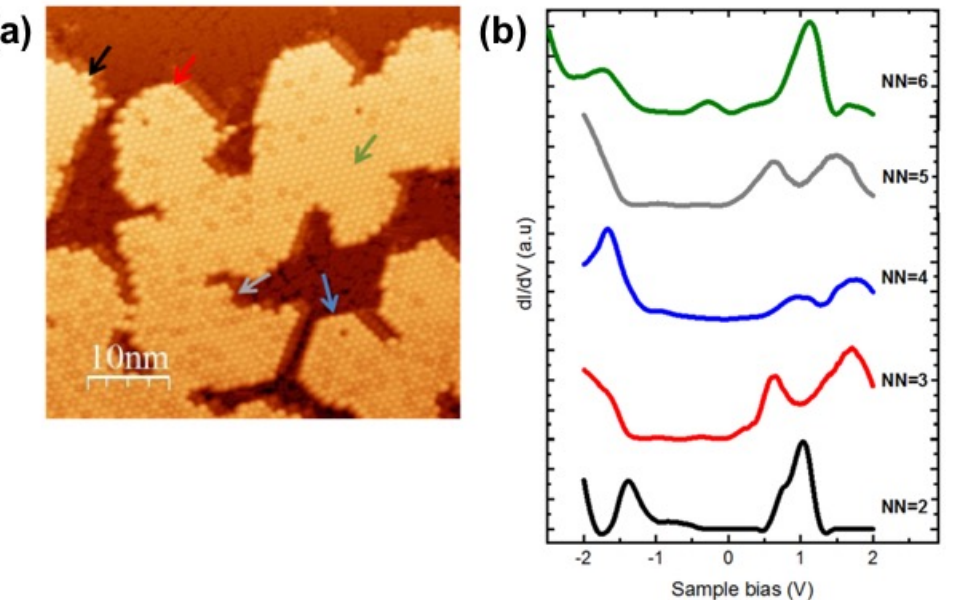
Figure 4. ( a ) STM topography of C 60 islands grown on ZnPc/Ag(111). The arrows are highlighting topography of C islands grown on ZnPc/Ag(111). The arrows are highlighting the different coordination of C 60 60 the different coordination of C 60 on top of the ZnPc layer. ( b ) Differential conductance spectra (dI/dV) on top of the ZnPc layer. ( b ) Differential conductance spectra (dI/dV) of C molecule absorbed on a monolayer 60 of C 60 molecule absorbed on a monolayer ZnPc on Ag (111) corresponding to different numbers of ZnPc on Ag (111) corresponding to different numbers of nearest neighbors in ( a ). STS were recorded for C nearest neighbors in ( a ). STS were recorded for C 60 molecules surrounded by 2 (black curve), 3 (red 60 curve), 4 (blue curve), 5 (grey curve), and 6 (green curve) C 60 molecule. Feedback loop was opened molecules surrounded by 2 (black curve), 3 (red curve), 4 (blue curve), 5 (grey curve), and 6 (green curve) C 60 at 0.7 nA and − 0.3 molecule. Feedback loop was opened at 0.7 nA and −0.3 V.